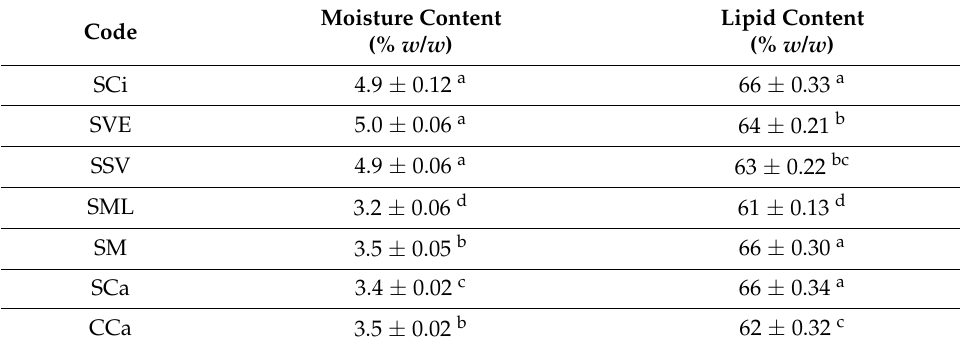
Table 4. Kernel moisture and lipid content ( n =